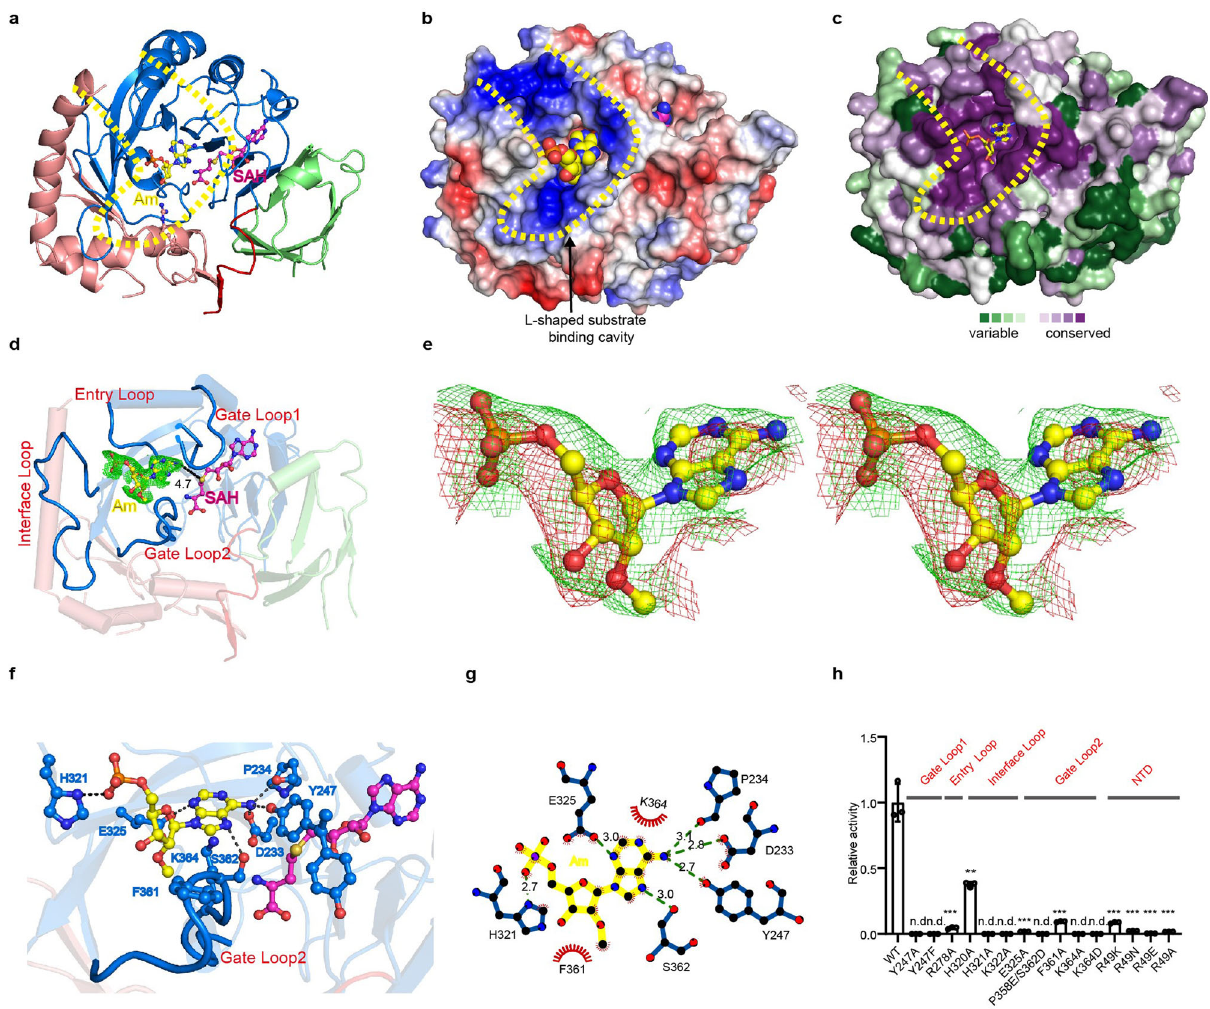
Fig.3|CrystalstructureoftheternarycomplexofMETTL4-Am-SAHuncoversa L-shaped cavity for the substrate binding and a conserved pocket for Am recognition. a Overall view of the METTL4-Am-SAH complex. b Electric surface of METTL4.Thepositivechargedcleftisoutlinedbyyellowdashedline,andtheAmis shownassphere. c ConSurfanalysisoftheconservationofMETTL4proteins. d Four conserved loops form substrate-binding cavity, and key residues involved in Am recognition are shown in stick and ball. The 2Fo-Fc map of Am is contoured at the 1.0 sigma level, and the invisible residues in electron density map of Gate Loop 1 shown asdashed lines. e Cross-eyedstereo view of the 2Fo-Fc map ingreencolor at 1.0 sigma level generated by CCP4 program and Fo-Fc omit map in red color at